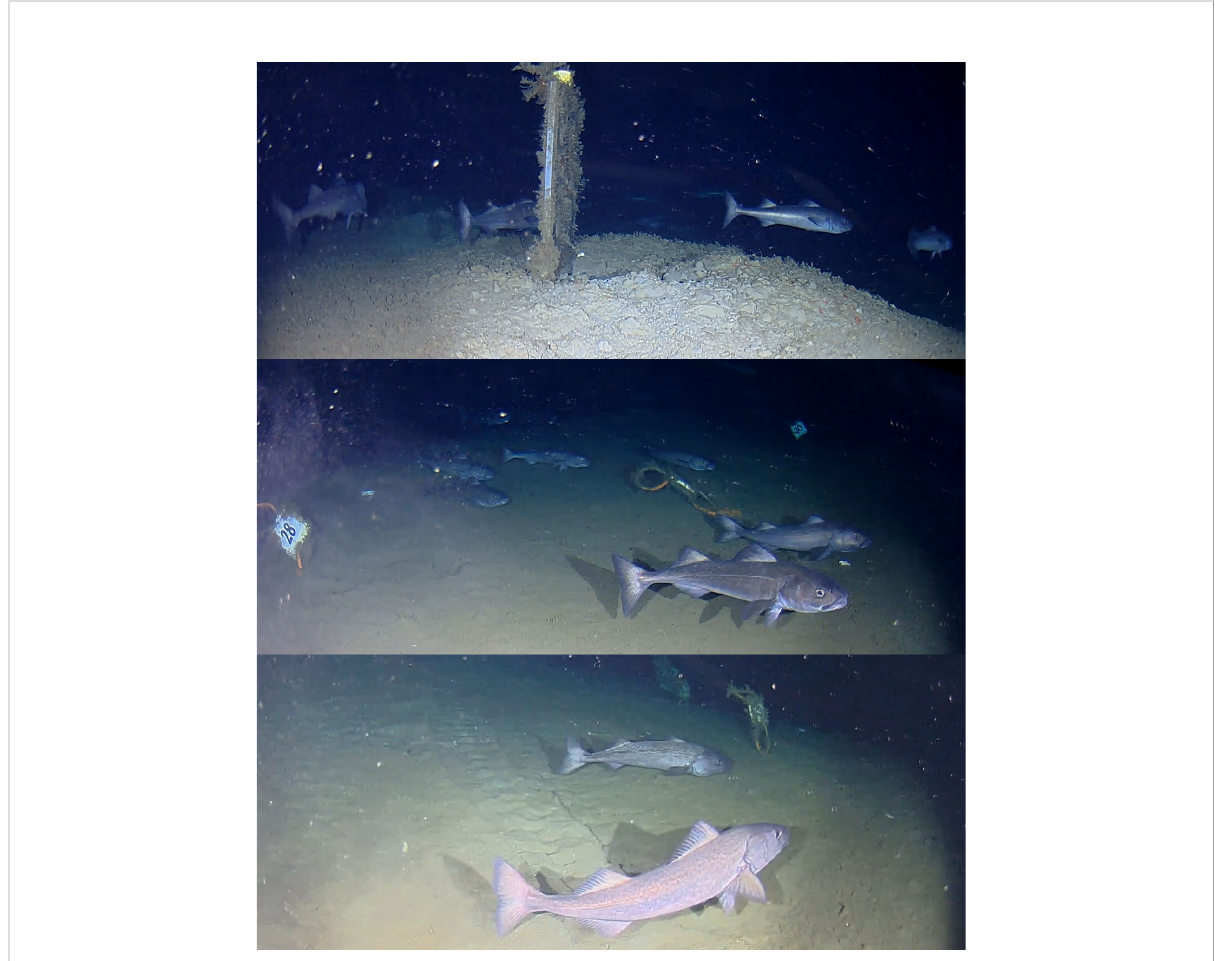
FIGURE 7 Sable fi sh resting on the seabed or hovering right above it, while all facing against the current (current direction from the right towards the left of the images). Images taken on August 24